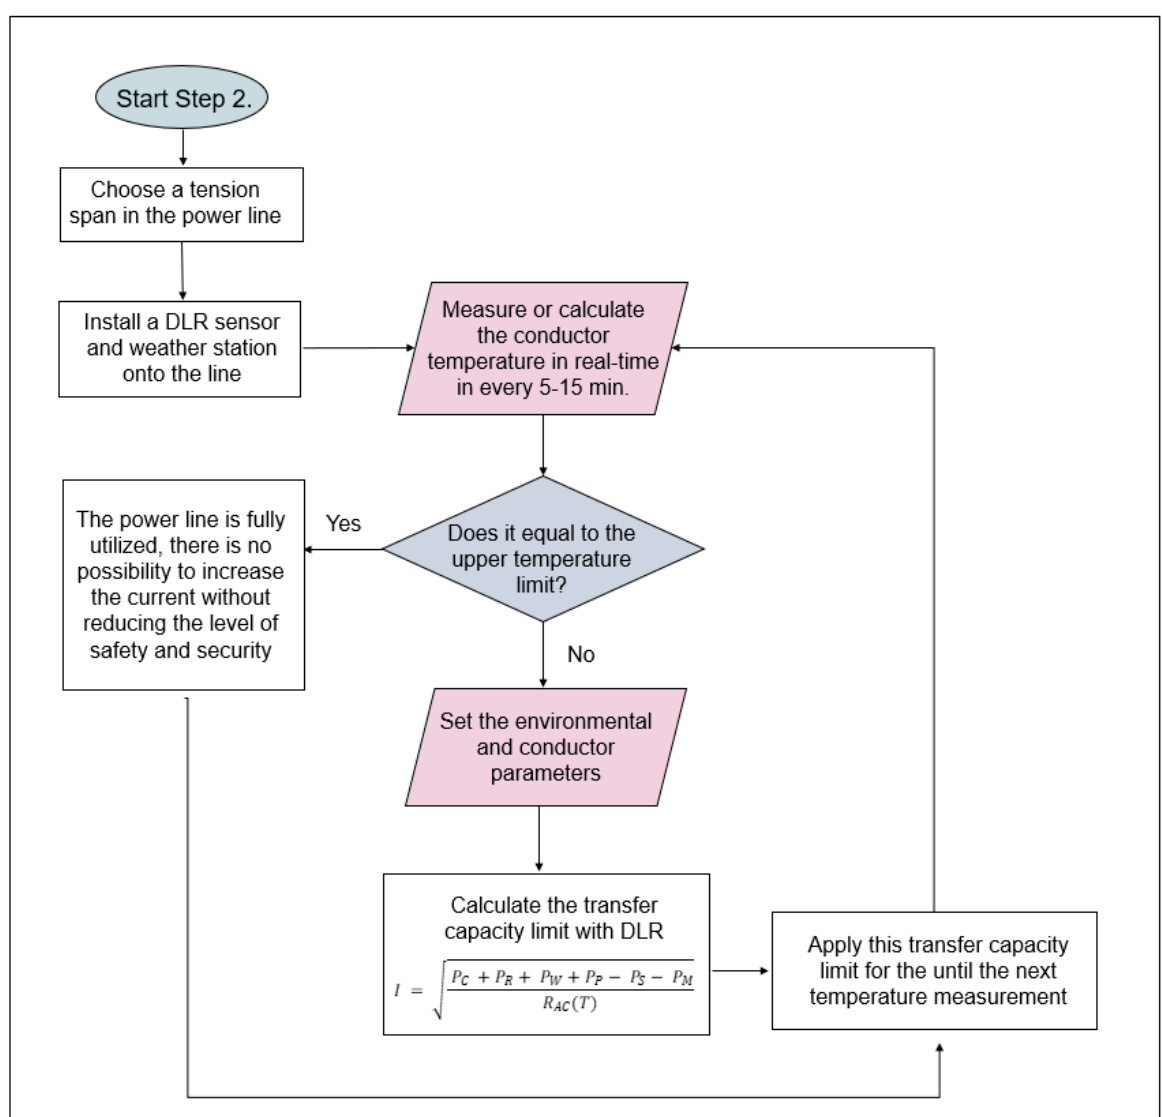
Figure 6. Process drawing of the second step of the new DLR-based expert system.